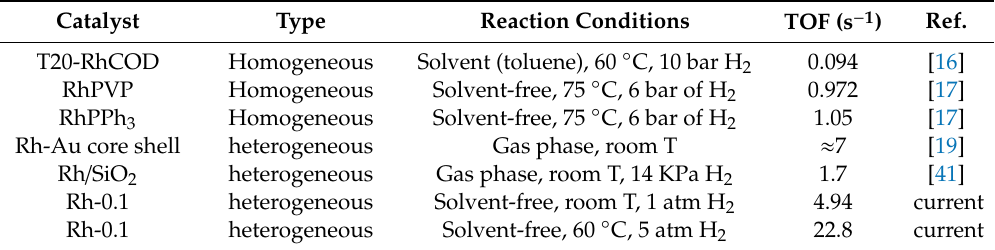
Table 2. A comparison between the catalytic activity expressed in the turnover frequency (TOF, s − 1 ) of the Rh-TUD-1 catalyst and other reported Rh-based homogeneous or heterogeneous catalysts.